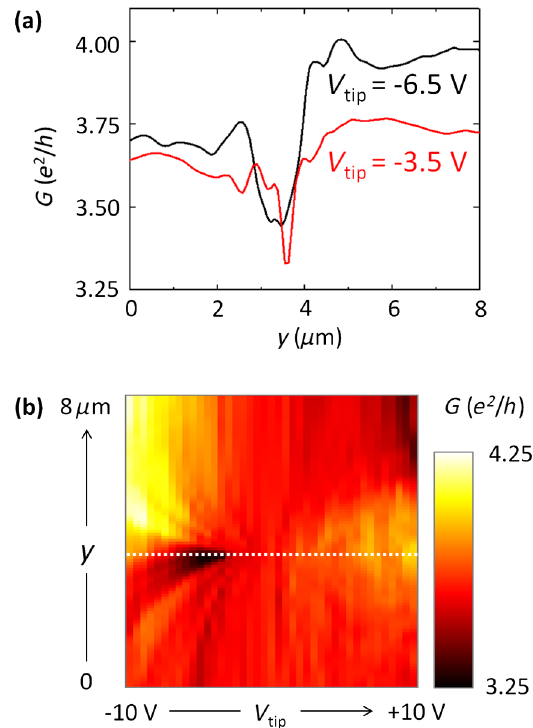
¼ tip ¼ (cid:2) 3 : 5 V (lower red trace) tip tip